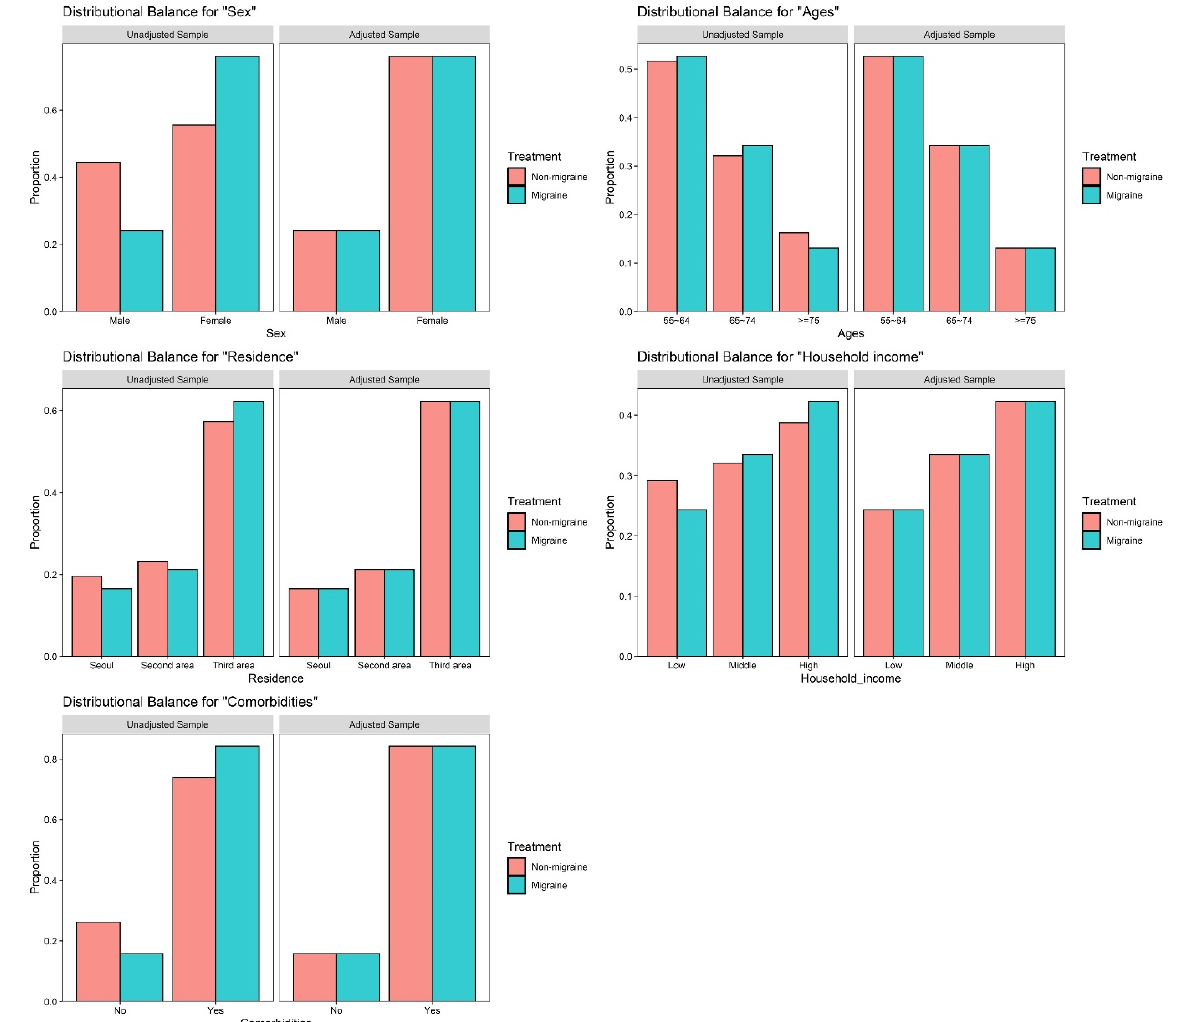
Figure 2. Balance plot for 5 variables before and after matching.